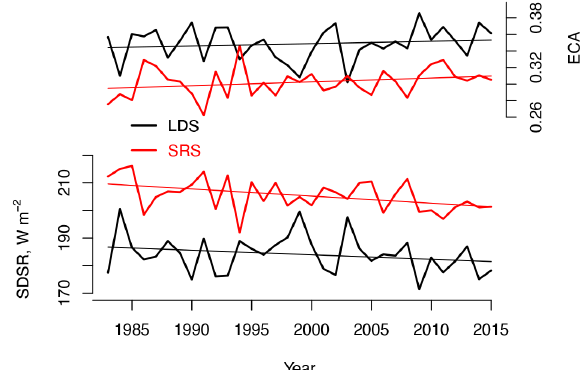
Figure 10. Trend in cloud cover. Trend in low and medium cloud cover based on station data from 1983–2015. Three squares for each station show trends for the three seasons FRS (left), LDS (centre), and SRS (right). For Parakou the second row shows the trend from 2001–2017 as in Fig. 12. For Lamto trends in total cloud area frac- tion between 2000 and 2015 are shown. Topography is shown in grey shadings. A * (**) marks statistically significant trends on the α = 20% (5%) level.